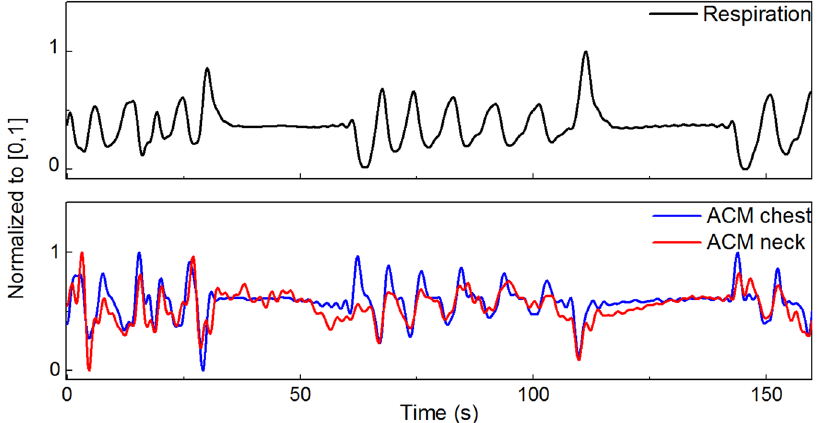
Figure 3. Breathing signal measured by respiration belt (top) and ACMs (down) during breath hold task. As can be seen breathing signal can be easily tracked also with ACMs placed on chest and neck. ACM placed on chest is more sensitive and corresponds better to respiration belt. In the ACM signal, corresponding breathing signal was processed by using a 0.5 Hz low pass filter 16 . Breath hold task was carried out between 30–60 s and 110–140